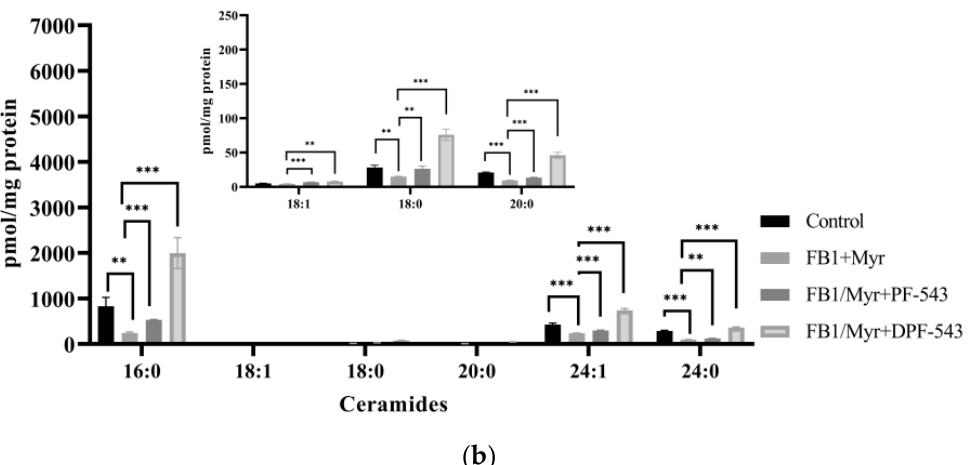
Figure 9. ( a ) PF-543 and DPF-543 impact on total ceramide accumulation mitigated by combined treatment of myriocin with FB-1; ( b ) alteration of individual ceramides by PF-543 and DPF-543 after combined treatment of myriocin with FB-1. Data are shown as means ± SD, ns—not significant, * p < 0.05, ** p < 0.01, *** p < 0.001.